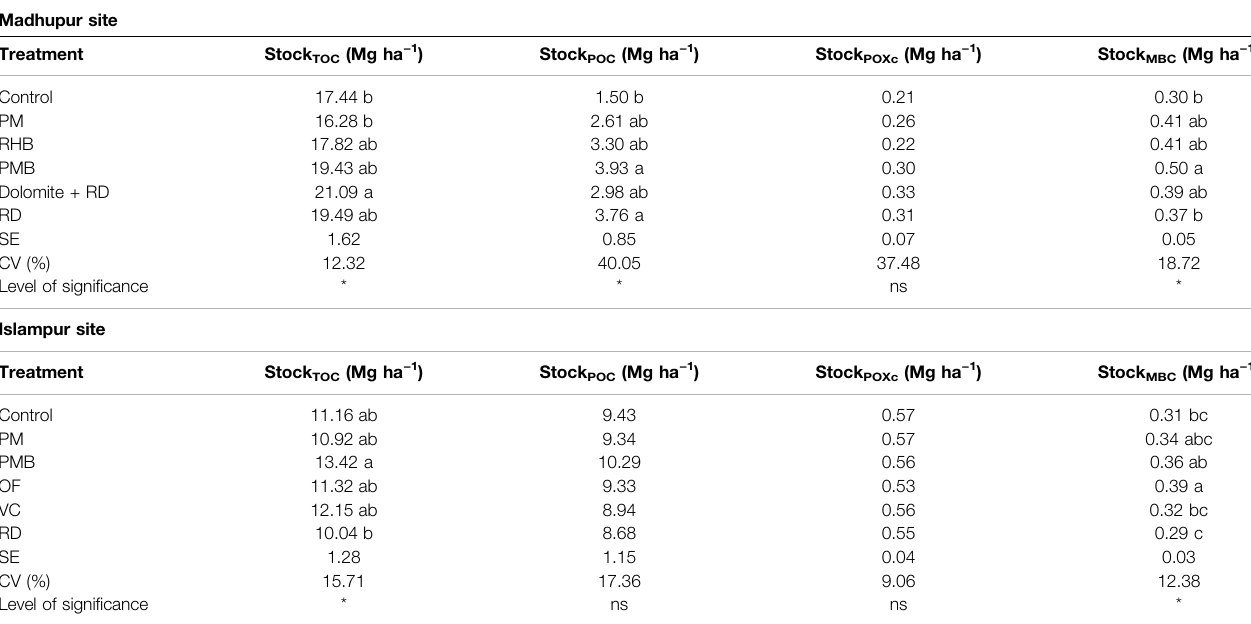
TABLE5| Effectsofdifferenttreatmentsontotalorganiccarbon,particulateorganicmatter,particulateorganiccarbon,permanganateoxidizablecarbon,microbialbiomass carbon stocks at Madhupur and Islampur sites at a depth of 0 – 15 cm. Madhupur site